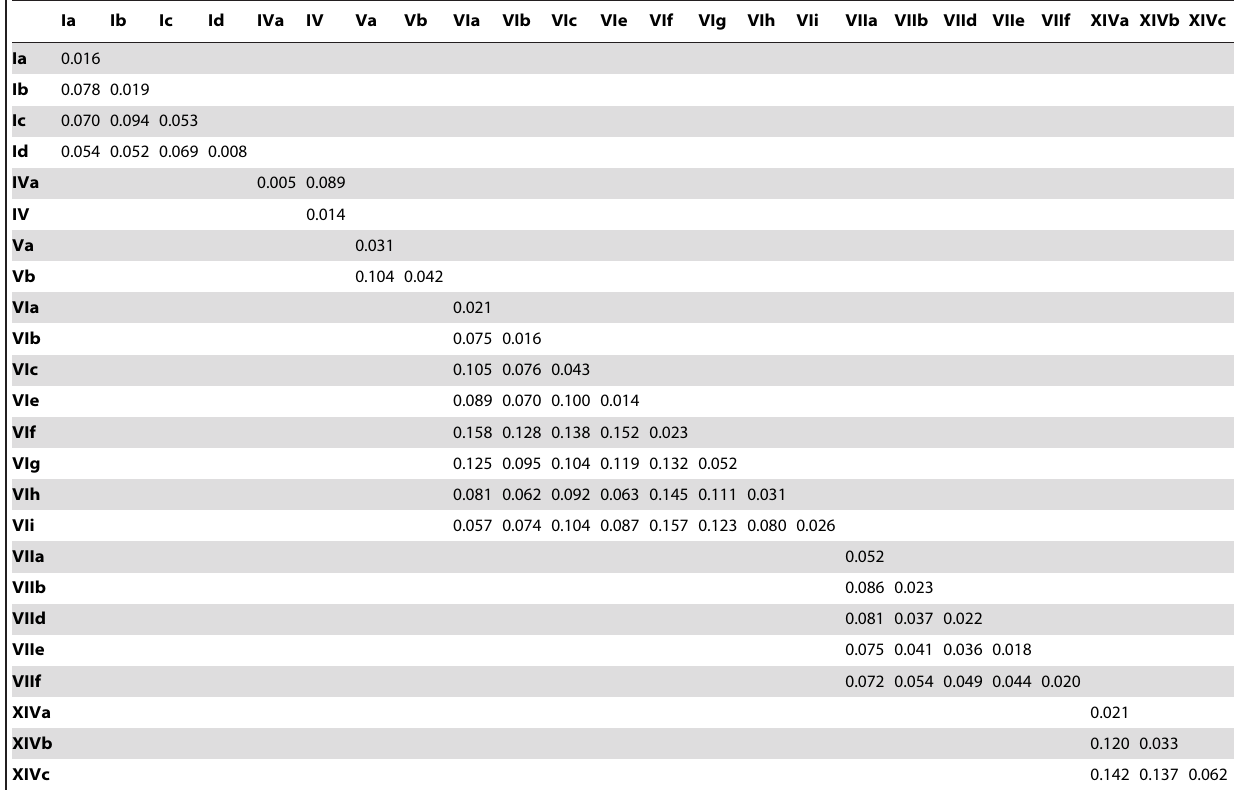
Average intra-subgenotype distance: 0.03.